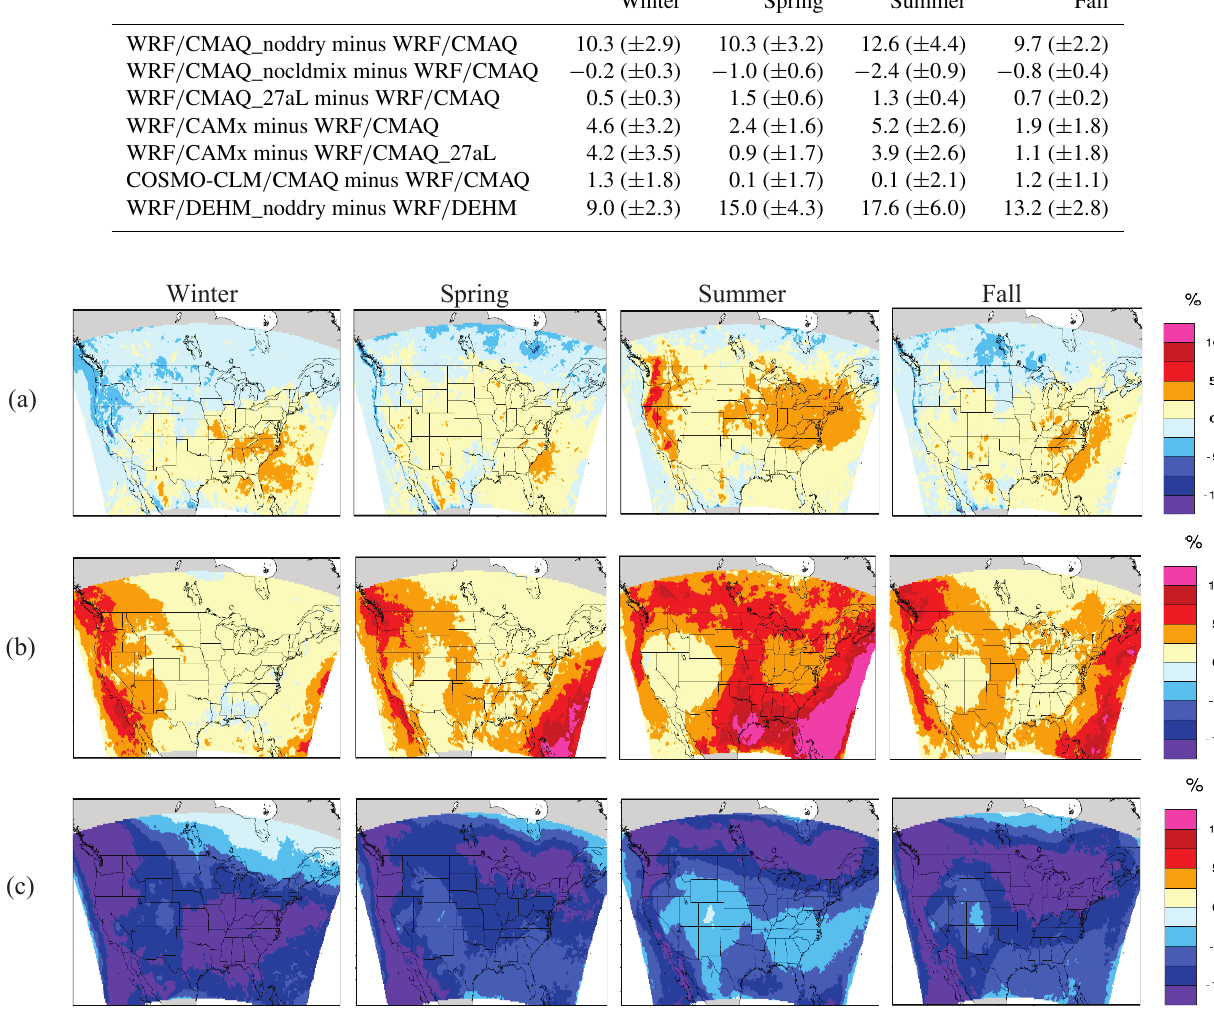
Figure 3. Differences in the seasonal averaged DM8A BC1 / BCT (%) between WRF / CMAQ_noddry and WRF / CMAQ (a) , between WRF / CMAQ_nocldmix and WRF / CMAQ (b) , and between WRF / CMAQ_27aL and WRF / CMAQ (c) . All results are shown as sensitivity simulation minus WRF / CMAQ. The areas in white or grey are the grid cells that are out of the simulation domain of WRF /